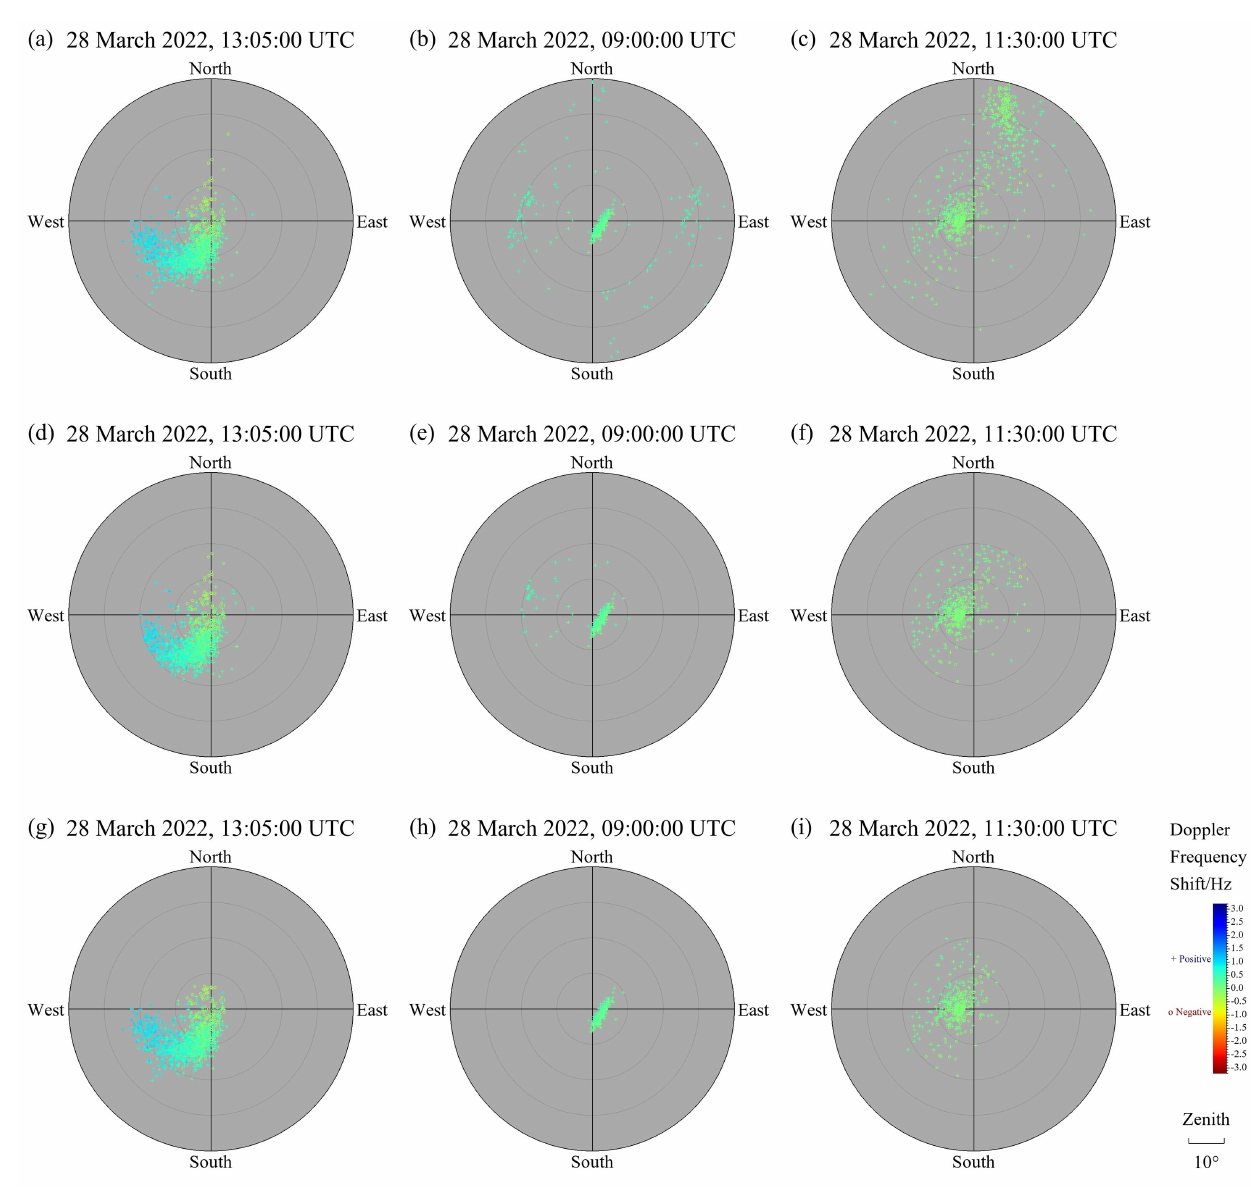
Figure 6. Cases of coarse clustering analysis. ( a – f ) No coarse clustering analysis. ( a – c ) Raw method: the maximum zenith angle is 40°. ( d – f ) Corrected Method 1: slightly improving the quality of reflection points by reducing maximum the zenith angle to 20°. ( g – i ) Corrected Method 2: effectively improving the quality of reflection points by applying coarse clustering analysis and maintaining the maximum zenith angle at